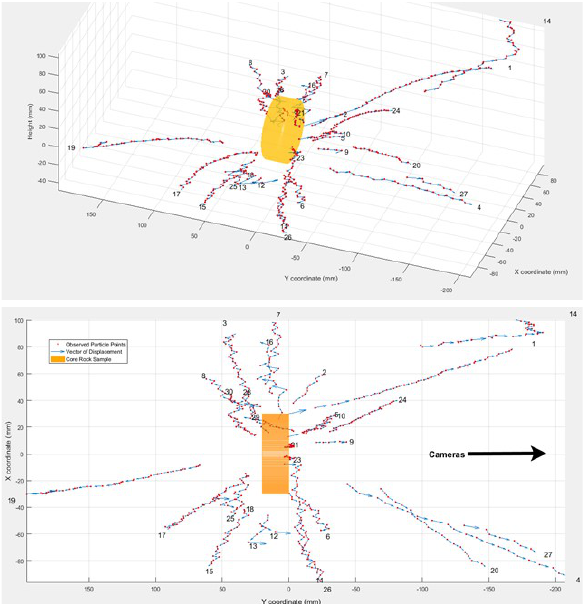
Figure 7. Displacement vectors of the progeny particles – perspective (top) and plan